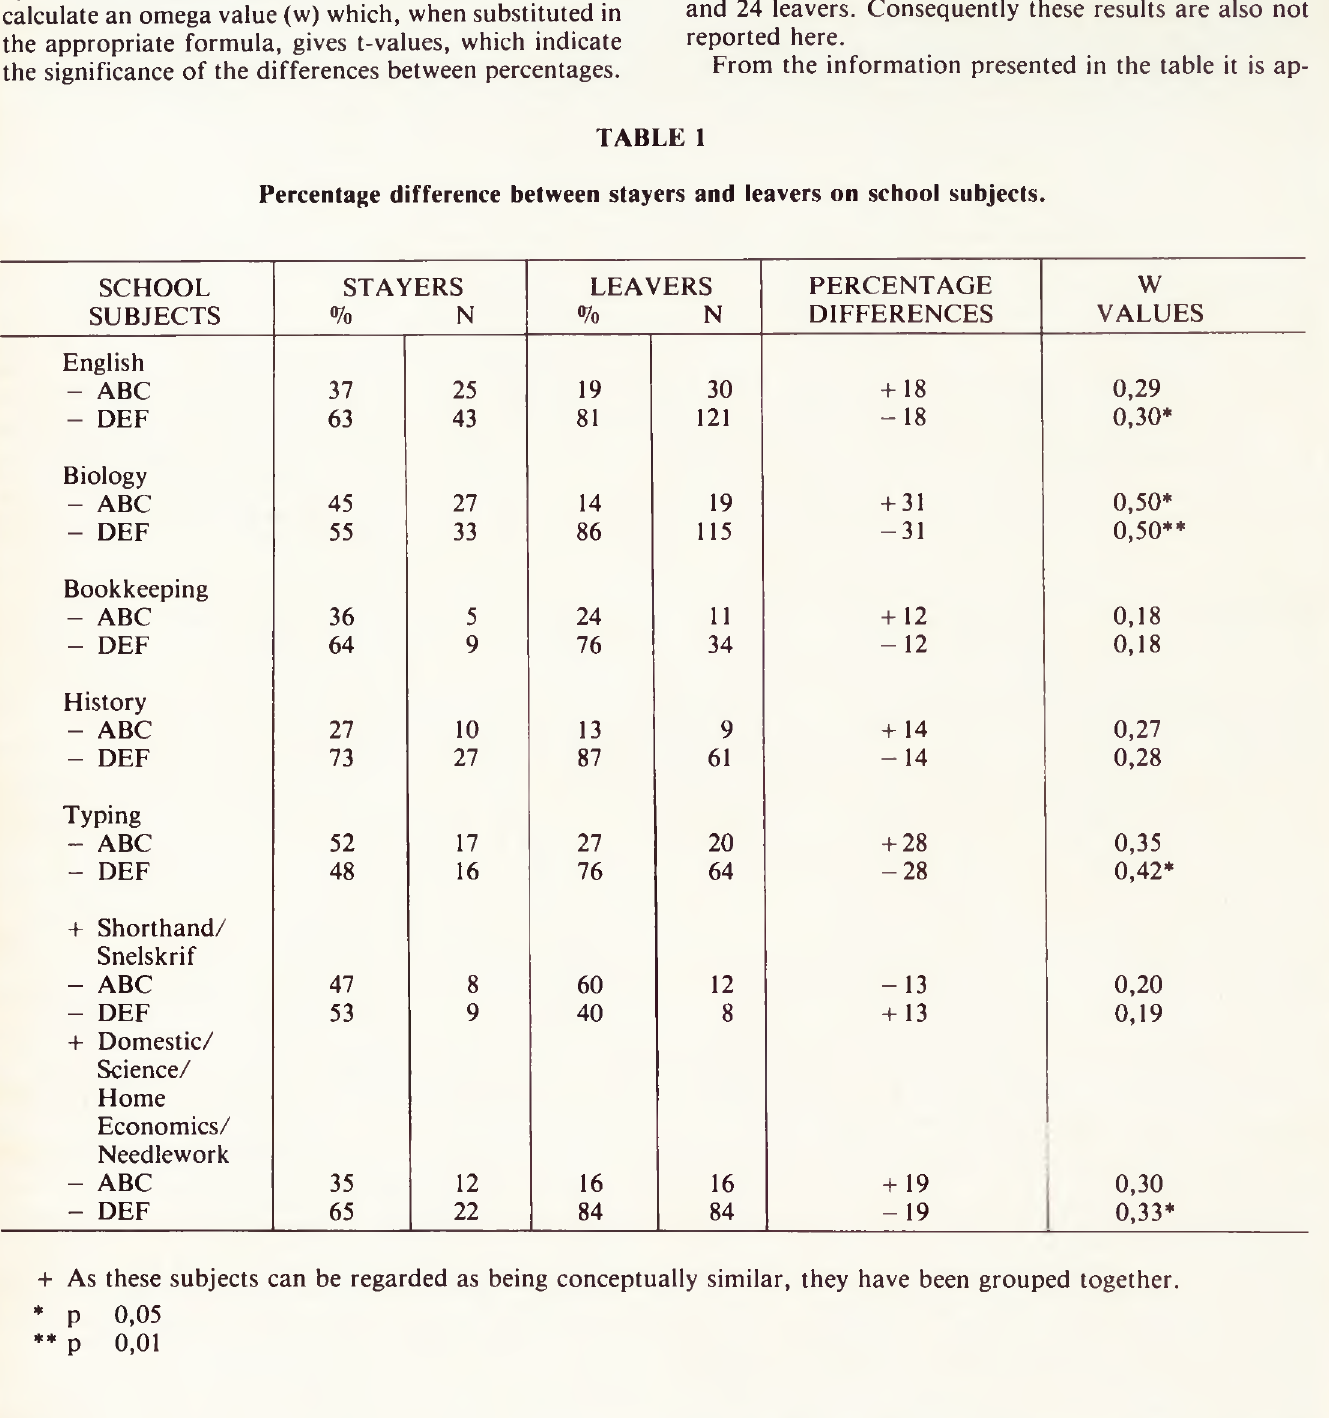
Percentage difference between stayers and leavers on school